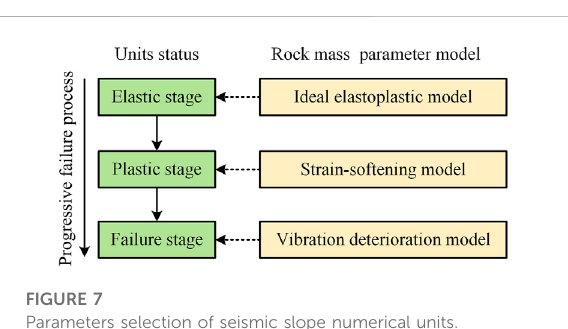
FIGURE 7 Parameters selection of seismic slope numerical units.